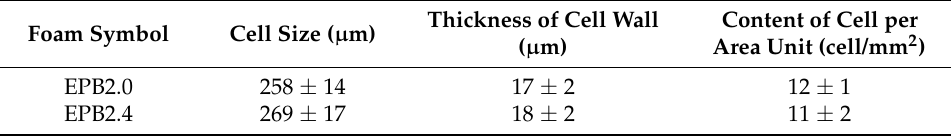
Table 6. Results of SEM micrograph analysis.